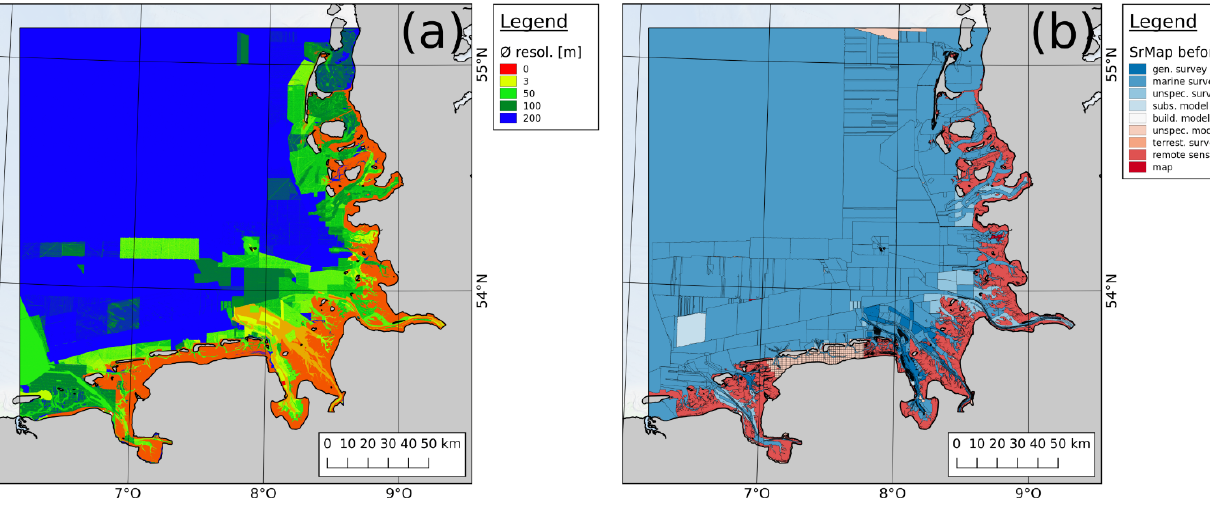
Figure 11. Plausibility products for 2016: (a) data density map and (b) data source map (before) with the survey type as displayed